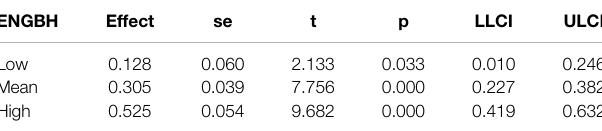
TABLE 6 | Conditional effects of the focal predictor at values of the